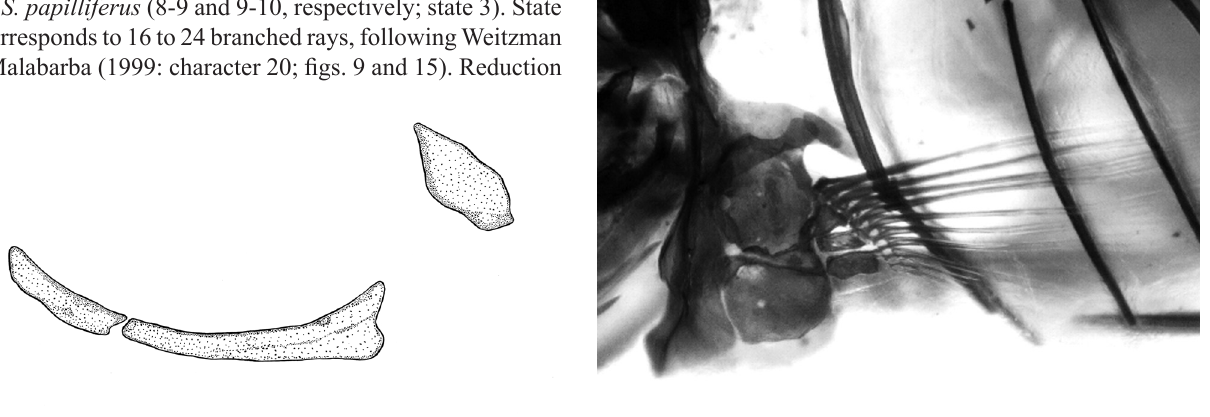
Fig. 12. Pectoral girdle of Amazonspinther dalmata showing the discoidal coracoid. Left side, external view (MCP 37572, 14.98 mm SL,